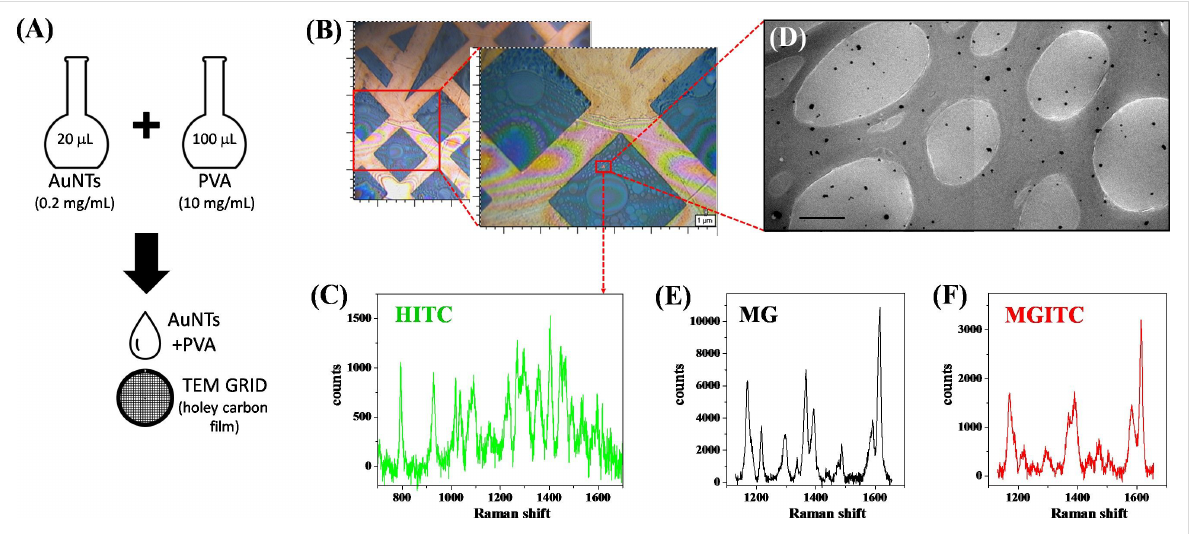
Figure 2: (A) Sketch of sample preparation for combined Raman and TEM analysis: 20 µL of an aqueous dispersion of AuNTs (0.2 mg/mL in Au) is mixed with 100 µL of an aqueous solution of PVA (10 mg/mL); after homogenization by ultrasonication, one drop of the mixture is deposited on a TEM grid coated with an holey carbon film. (B) 20× and 50× optical microscope images of the TEM grid coated with the PVA film embedding HITC–AuNTs. Some points of the grid are analyzed by Raman spectroscopy to collect the Raman spectra (C) and imaged with TEM (D) to obtain the surface densi- ty of the AuNTs. (E,F) Representative Raman spectra of MG and MGITC AuNTs collected with the same